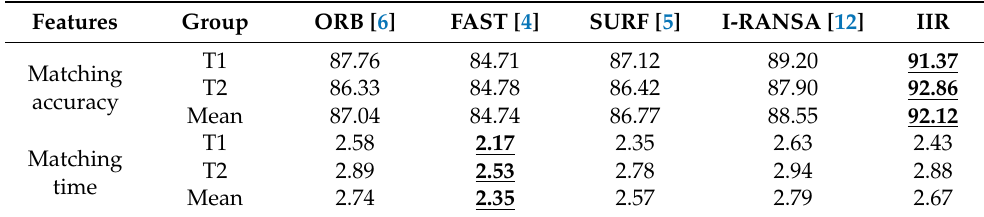
Table 3. A comparison of the matching accuracy and matching time between different